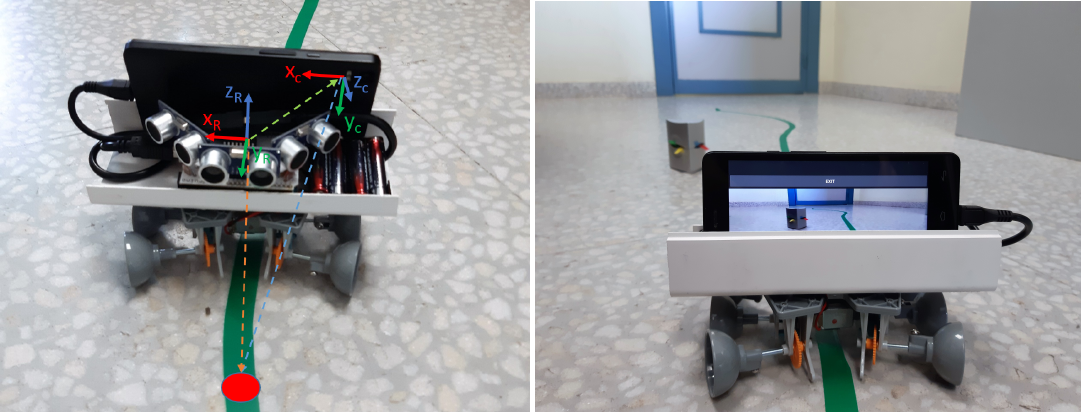
Figure 7. Local and camera reference frames in Andruino-R2 ( left ). Image seen from the on-board camera when the robot is centered on the line ( right